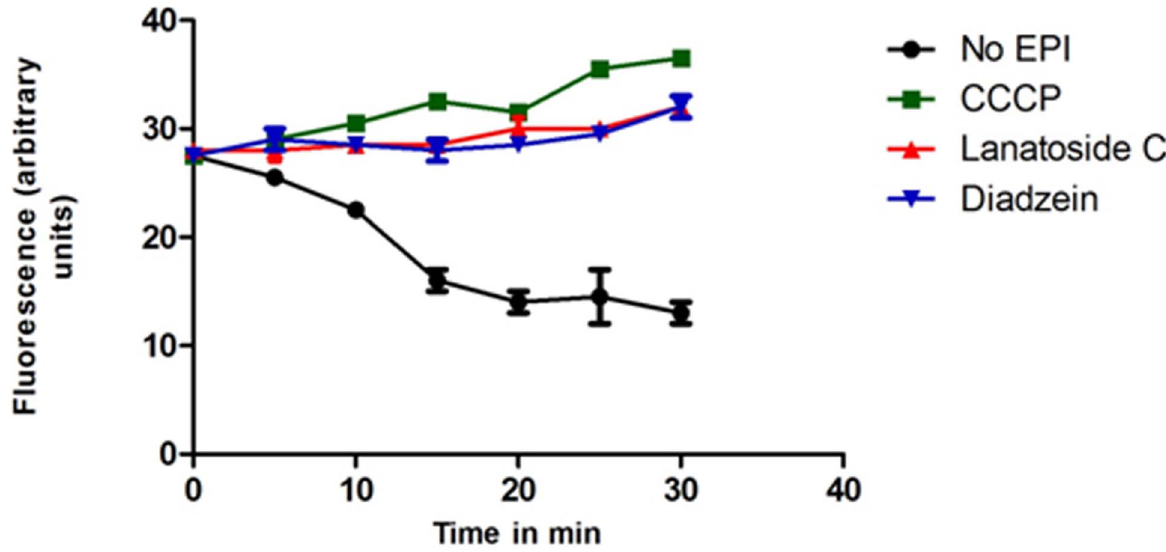
Figure 6. Effect of efflux inhibitor, CCCP and phytochemicals in accumulation of ethidium bromide in E.coli strain.